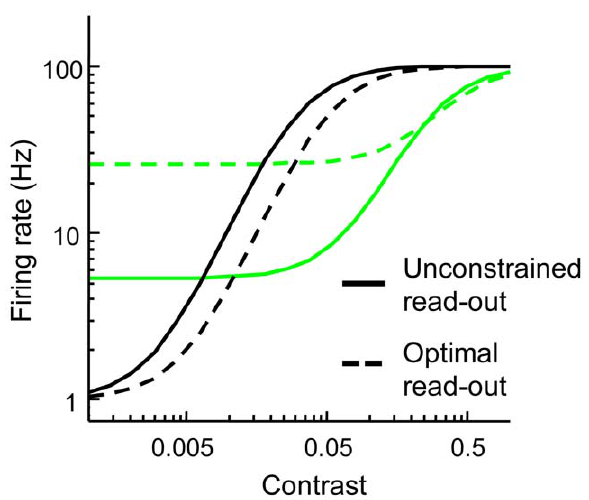
Figure 5. Best-fitting contrast response functions assumed in our population code model in which read-out function width is either a free parameter (full lines) or infinitely narrow (broken lines). Green and black lines respectively indicate the contrast response to gratings embedded in white noise and presented in the absence of noise.